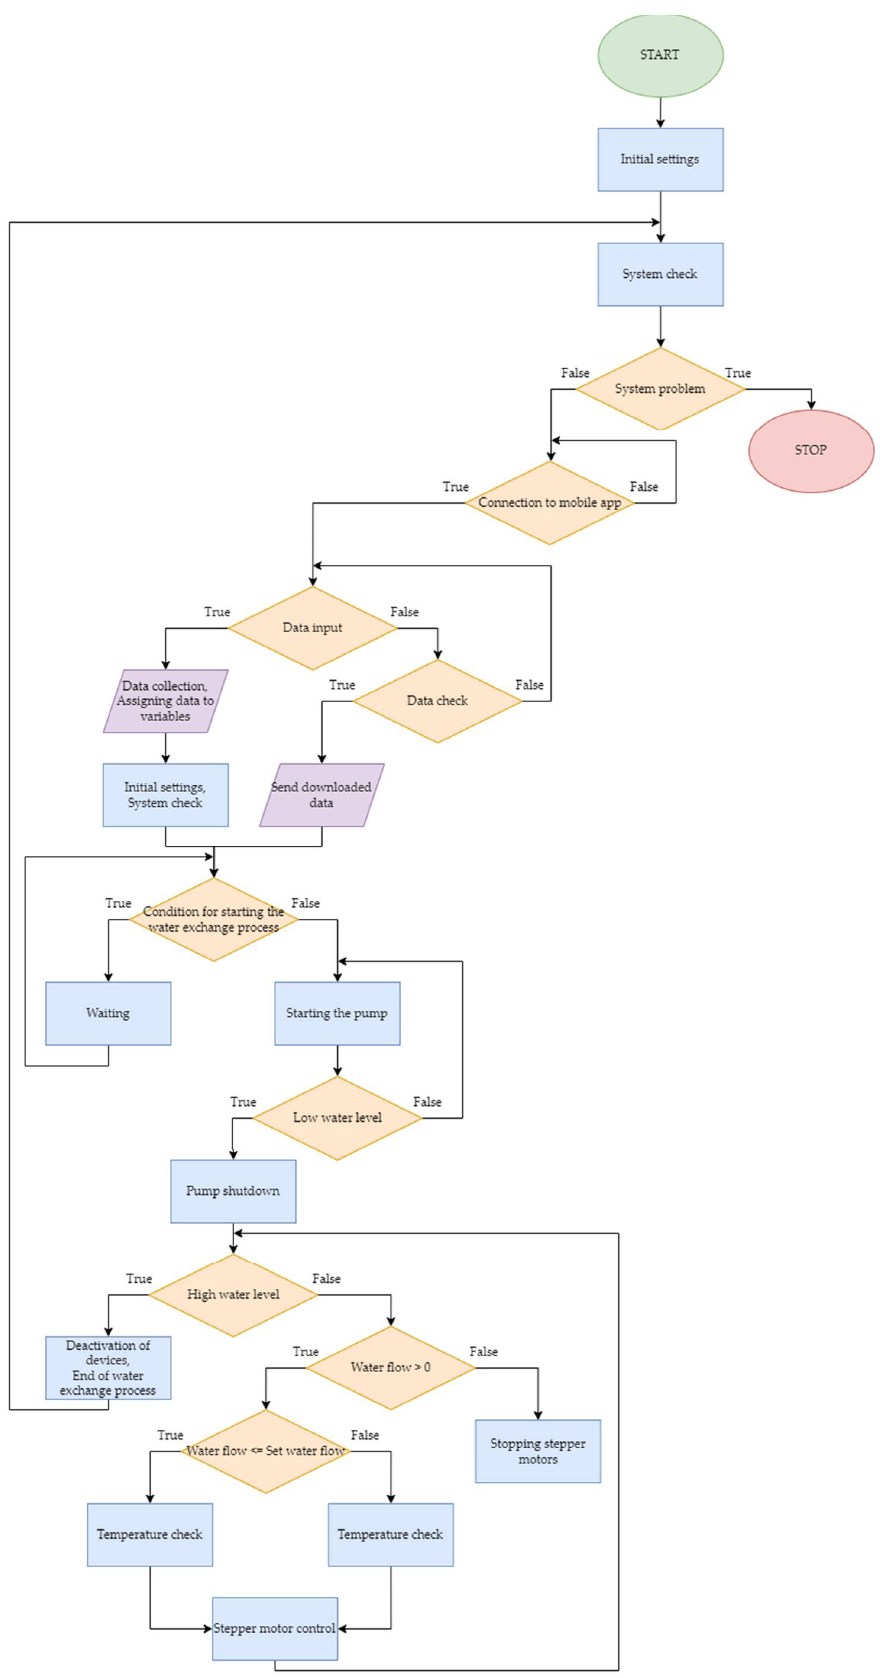
Figure 4. Operating diagram of the